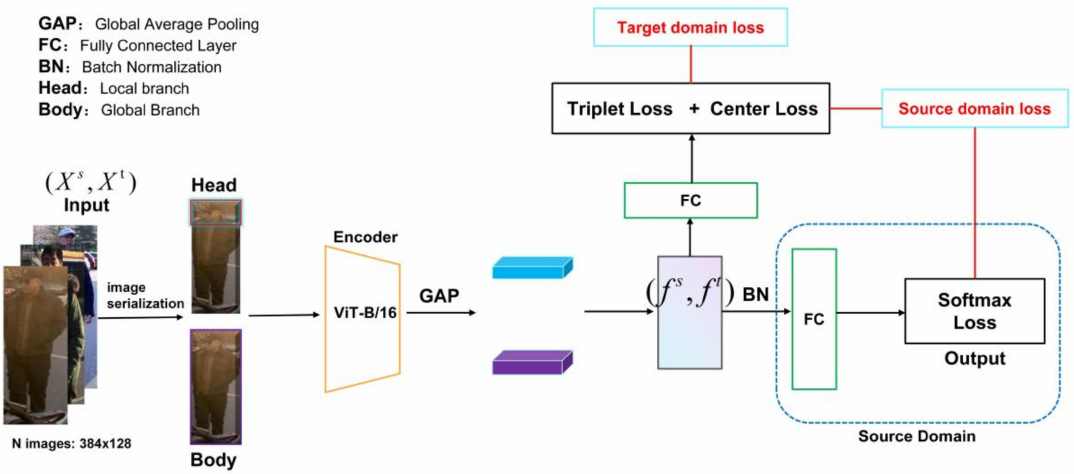
Figure 1. Diagram of the ViTReID network